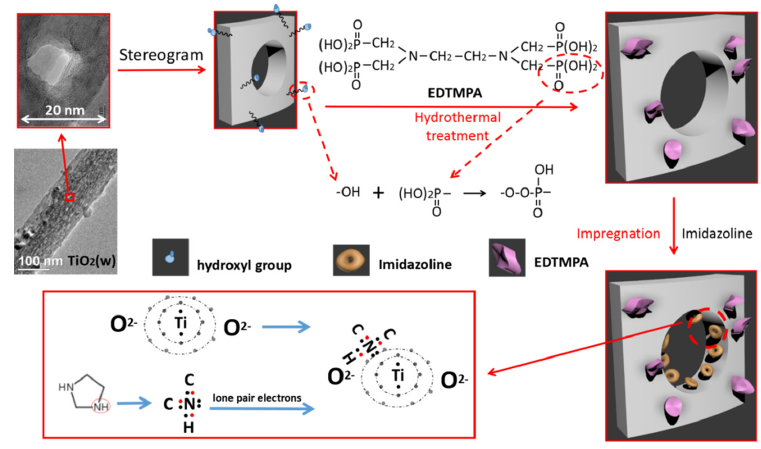
Figure 3. Modification of the carriers by EDTMPA and imidazoline.